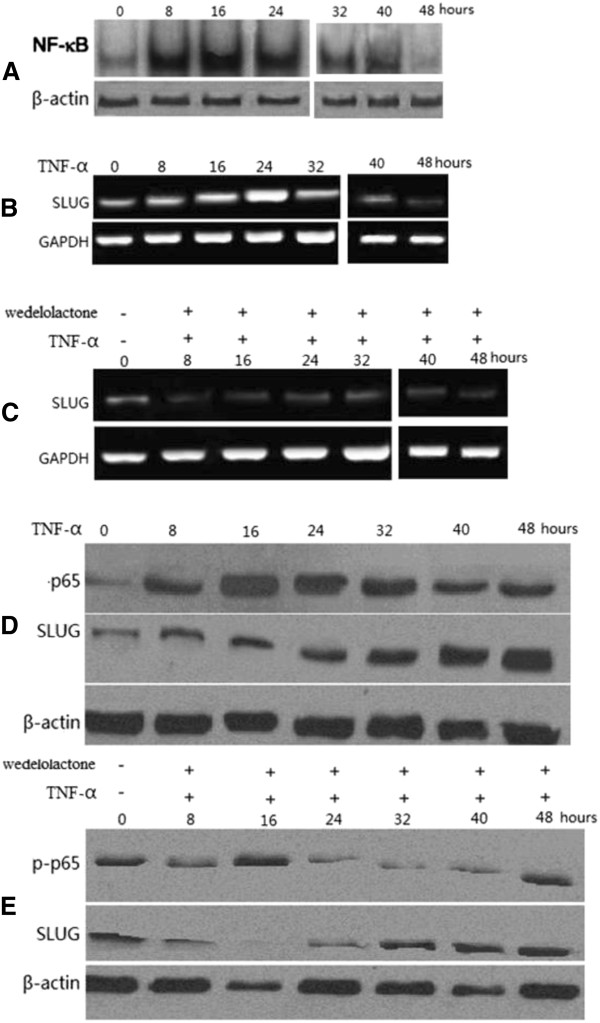
Effect of TNF-α on nuclear factor kappa B (NF-κB) and SLUG expression. Lung cancer cells were treated with 20 ng/ml TNF-α. NF-κB transactivation function was determined by electrophoretic mobility shift assay. SLUG mRNA and protein at different time points after treatment were analyzed by reverse transcription PCR(RT-PCR) and western blotting, respectively. (A) NF-κB transactivation function was determined by electrophoretic mobility shift assay at different time points after TNF-α treatment. (B) Time course of SLUG mRNA induction by TNF-α in A549 lung cancer cells. Glyceraldehyde-3-phosphate dehydrogenase (GAPDH) was a control. (C) Time course of SLUG mRNA induction with or without TNF-α/wedelolactone in A549 lung cancer cells. GAPDH was a control. (D) Time course of SLUG protein induction by TNF-α in A549 cells. Phospho-p65 and β-actin were also analyzed. (E) Time course of SLUG and phospho-p65 protein induction with or without TNF-α/wedelolactone in A549 lung cancer cells.